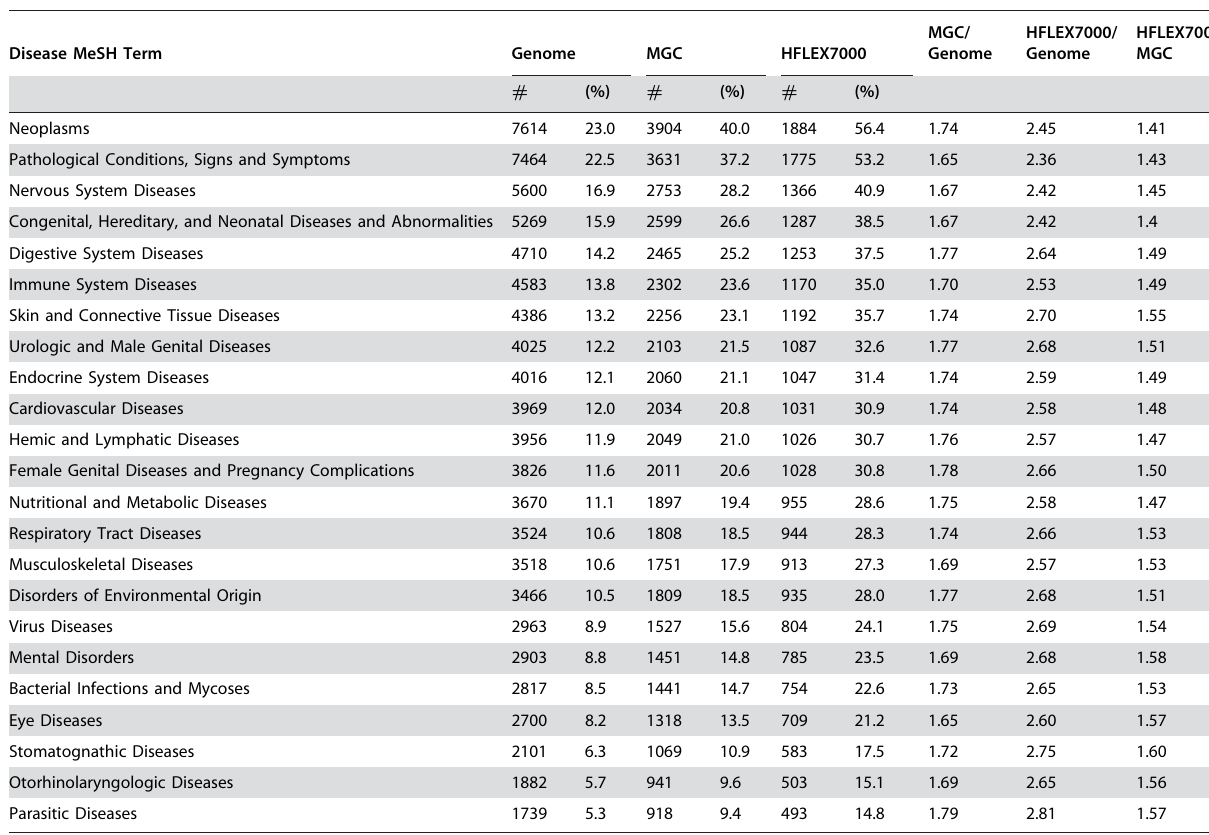
Examples of MedGene analysis of disease term association with genes in PubMed, using either all human genes (2004), unique genes in MGC (2004), or HFLEX7000 (targets). Numerical values and percentiles of each class associated with genes are shown. Relative MeSH term associations in either MGC or HFLEX7000 to the genome, and in HFLEX7000 to MGC examine a potential bias in MGC or HFLEX7000 towards specific MeSH terms.